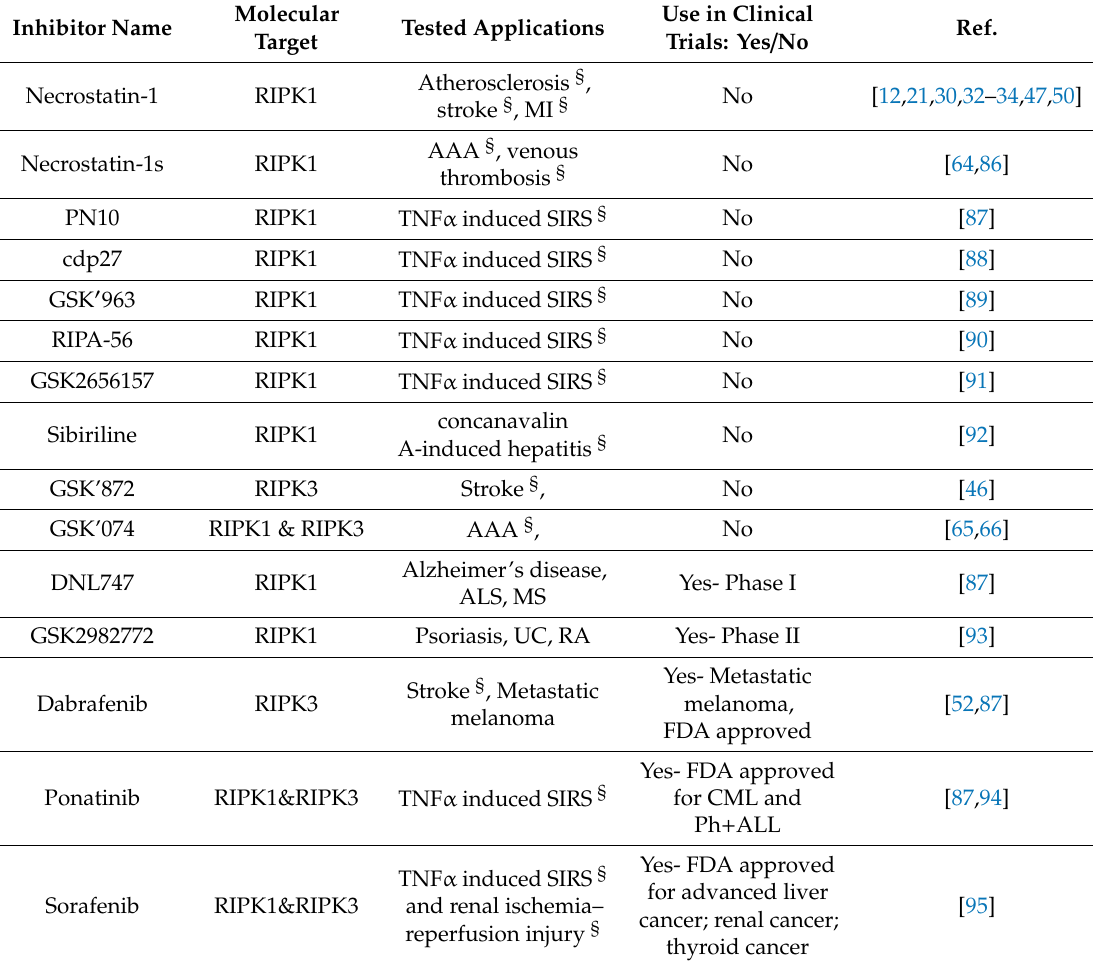
Table 2. a Summary of Receptor Interacting Protein Kinase Inhibitors Tested in and Beyond Cardiovascular